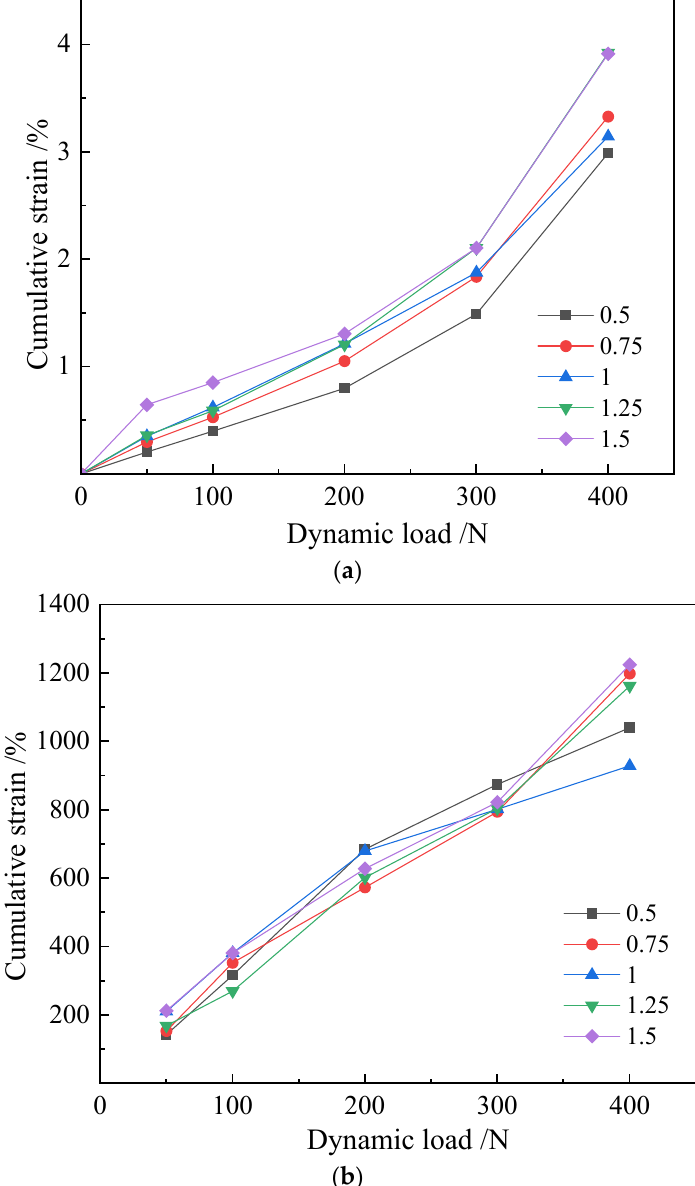
Figure 5. E scheme sample. ( a ) Cumulative strain curve; ( b ) resilience modulus Ed versus dynamic load curve.